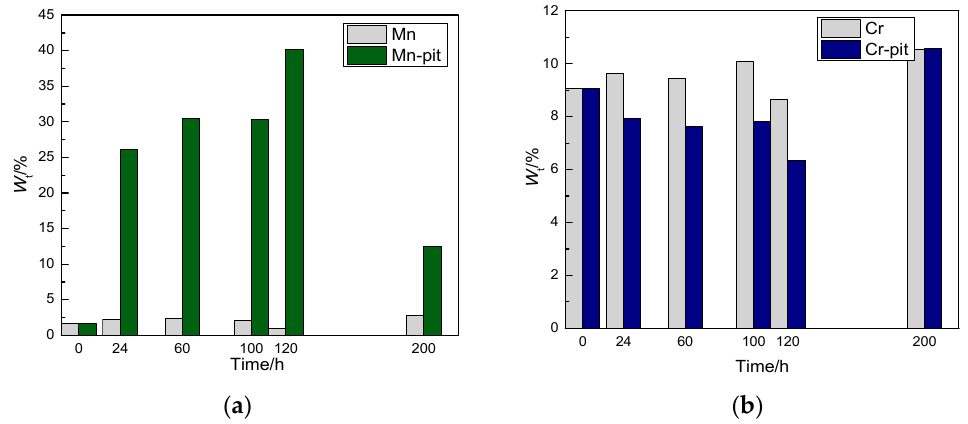
Figure 10. Analysis of the chemical elements inside and outside of the corrosion pits at different corrosion exposure times in corrosion-resistant alloy steel bars. (O-pit represents the O content inside the pits, Fe-pit represents the Fe content inside the pits). ( a ) O element contained in inside and outside of the corrosion pits; and ( b ) Fe element contained in inside and outside of the corrosion pits.